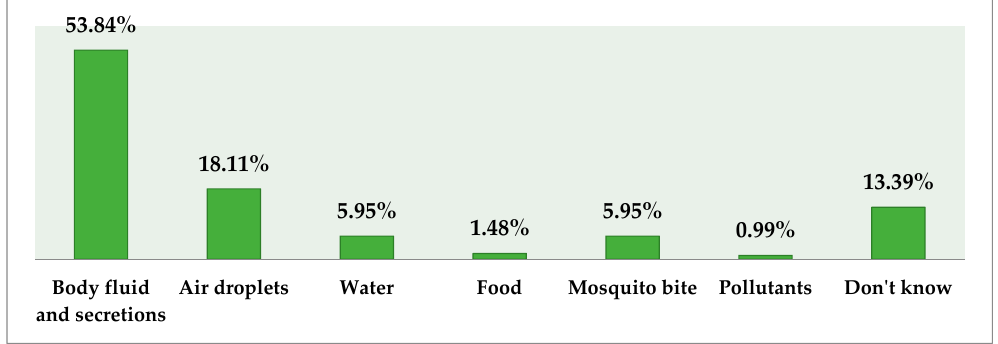
Figure 2. Respondents’ beliefs regarding source of EVD infection (%).